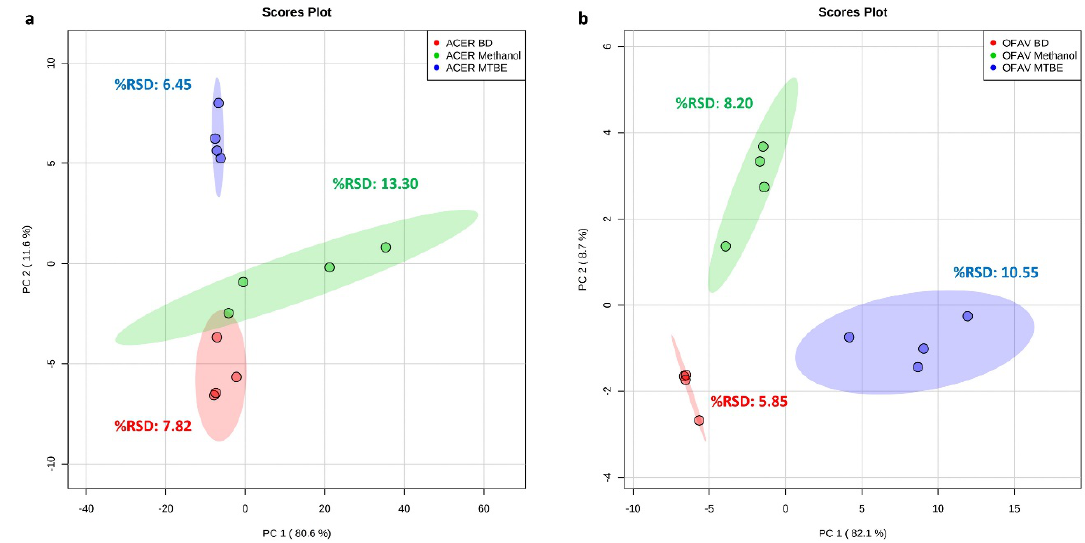
Figure 2. Principal component analysis (PCA) score plot and spectral relative standard deviation (%RSD) of three extraction methods ( n = 4) for frozen homogenates of ( a ) Acropora cervicornis (ACER) and ( b ) Orbicella faveolata (OFAV). Ellipses indicate the 95% confidence region for each extraction method. BD = Bligh and Dyer extraction; Methanol = methanol extraction; MTBE = methyl tert -butyl ether extraction.